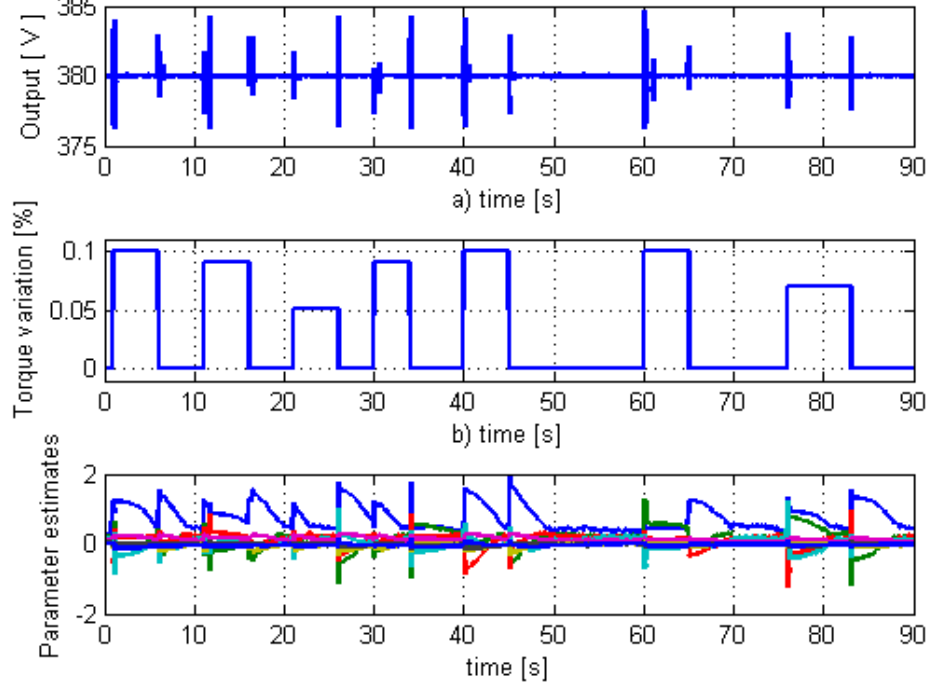
Figure 14. Robustness test (mechanical torque variations): ( a ) Controlled output (terminal voltage); ( b ) Mechanical torque variation (disturbance); ( c ) Parameters estimates.